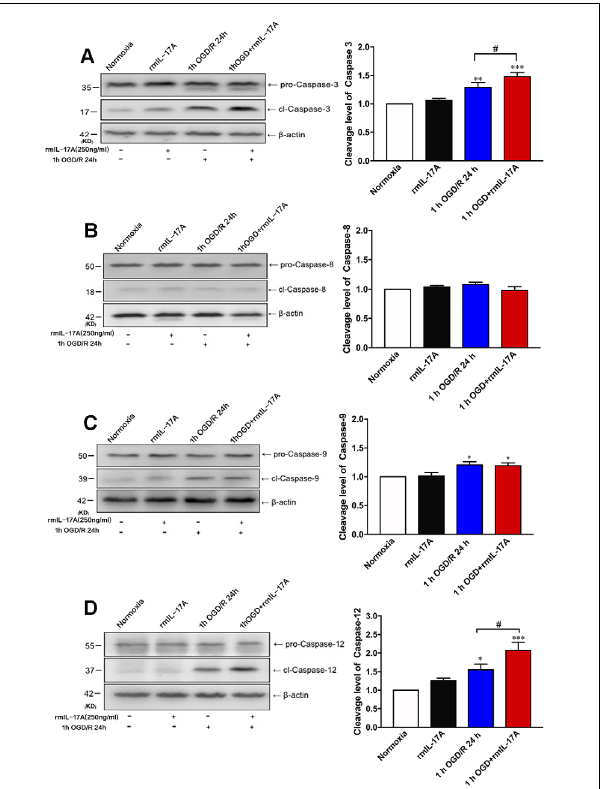
FIGURE 5 | Effect of rmIL-17A on cell apoptosis in 1-h OGD/R 24-h-treated primary cortical neurons. The representative and quantitative analysis results of Western blot demonstrated that rmIL-17A (250 ng/ml) could remarkably exacerbate the cleavage levels of caspase-3 (A) and caspase-12 (D) in 1-h OGD/R 24 - h-treated cortical neurons. However, the rmIL-17A treatment did not affect the cleavage levels of caspase-8 (B) and caspase-9 (C) in primary cortical neurons under the condition of 1-h OGD/R 24 h. Data are presented as mean ± SEM; ∗ p < 0.05, ∗∗ p < 0.01, ∗∗∗ p < 0.001 vs. normoxic group; # p < 0.05 vs. 1-h OGD/R 24-h group ( n = 6 per